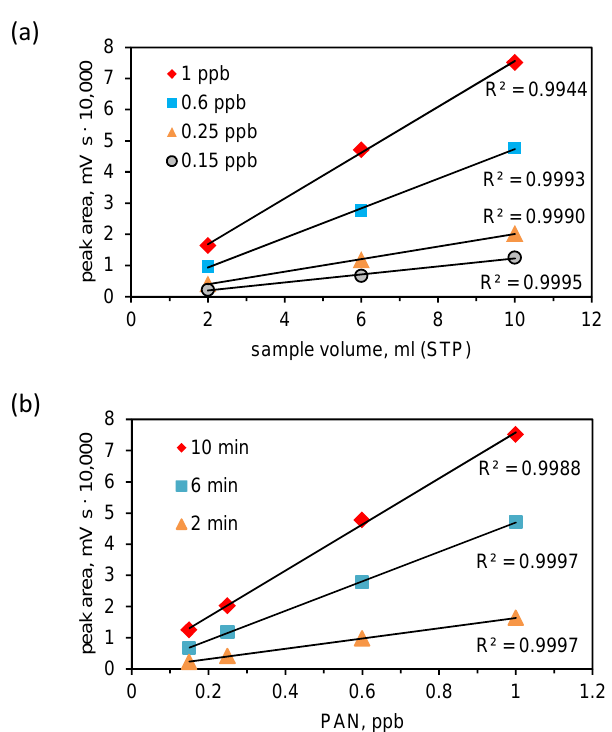
Figure 5. Results of a multi-step calibration experiment illustrating Figure 5: Results of a multi-step calibration experiment illustrating the linear relationship between (a) 1 the linear relationship between (a) the area of the PAN peak and the area of the PAN peak and the sample volume (STP) for various PAN mixing ratios as well as (b) 2 the sample volume (STP) for various PAN mixing ratios as well as (b) the area of the PAN peak and PAN mixing ratios for differ- the area of the PAN peak and PAN mixing ratios for different loading times of the PCUs. Since the 3 ent loading times of the PCUs. Since the flow rate through the pre- concentration unit was regulated by a mass flow controller, both the flow rate through the pre-concentration unit was regulated by a mass flow controller, both the 4 loading time and the sample volume are linearly proportional to the mass of the sampled air loading time and the sample volume are linear proportional to the mass of the sampled air volume. 5